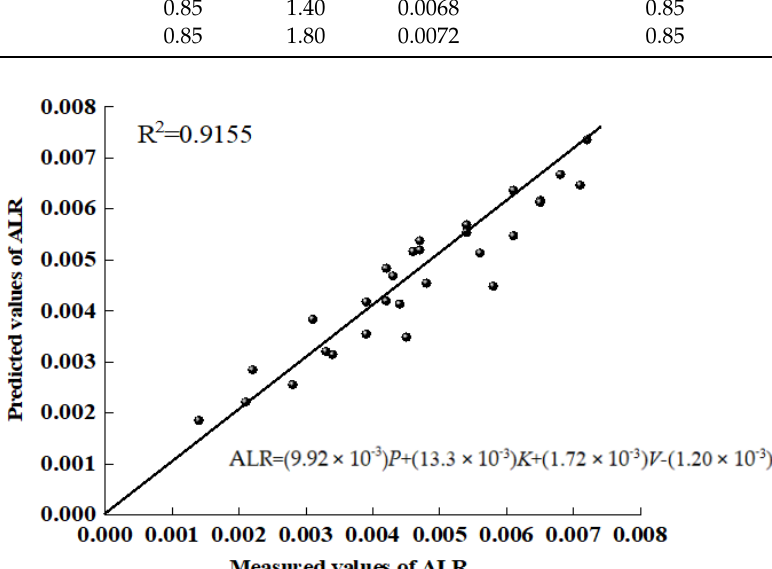
Figure 13. TD-ST combined AIN air-liquid ratio regression model. Table 4. Coefficient table of fitted equations.